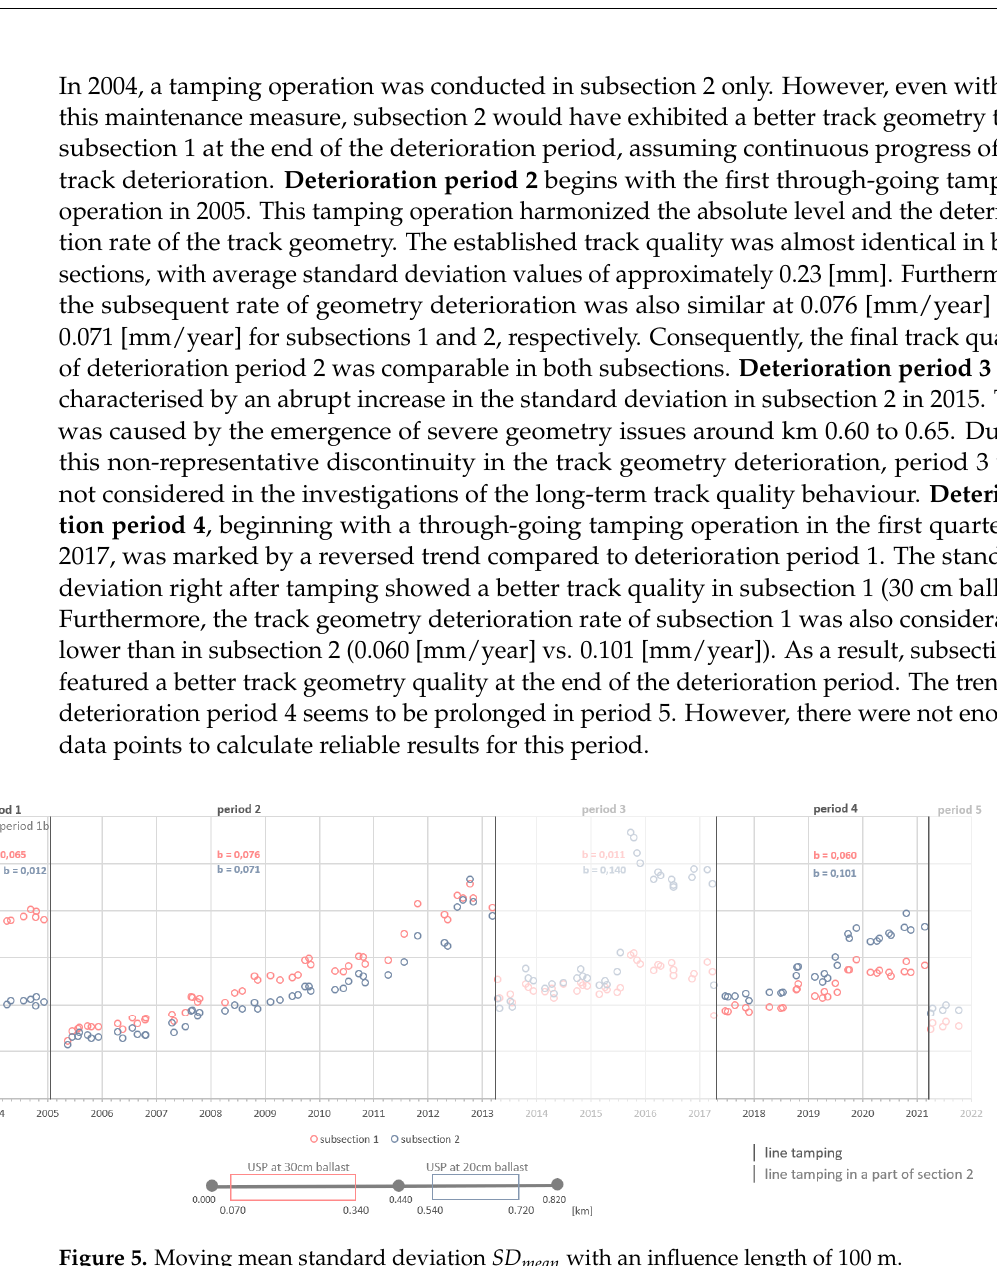
Figure 5. Moving mean standard deviation SD mean with an influence length of 100 m.